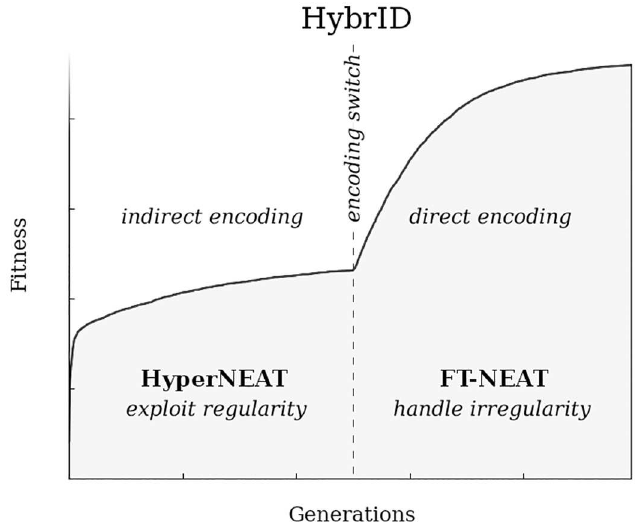
Fig 3. The HybrID algorithm. Individuals are initiallyindirectly encoded(here, with HyperNEAT) to exploit problemregularities.At the encoding switch point (dashedvertical line), individuals are convertedto a direct encoding (here, FT-NEAT) to further improve performance by handlingirregularitiesof the problem. Adapted from [24].